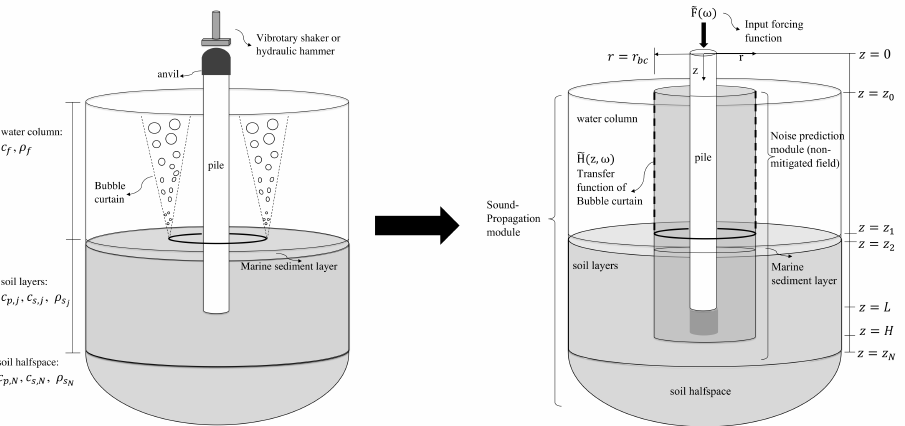
Figure 1. Schematic of the complete system ( left ) and the coupled model ( right ). c f is the sound speed and ρ f is the density of the water; c p , j and c s , j are the compressional and shear wave speeds, respectively; ρ s , j is the density of the soil with the index j = 1,2, ..., N specifying the soil layers and the bottom soil half-space; (cid:101) F ( ω ) is the forcing function; (cid:101) H ( z , ω ) is the transfer function of the air bubble curtain; r bc is the radial distance of the air bubble curtain; z 0 is the level of the sea surface; z 1 is the level of the seabed, z j is the bottom level of the ( j − 1 ) th soil layer ( j = 2,3,..., N ); L indicates the level of the bottom of pile tip; and H indicates the level of the rigid boundary applied in the sound generation